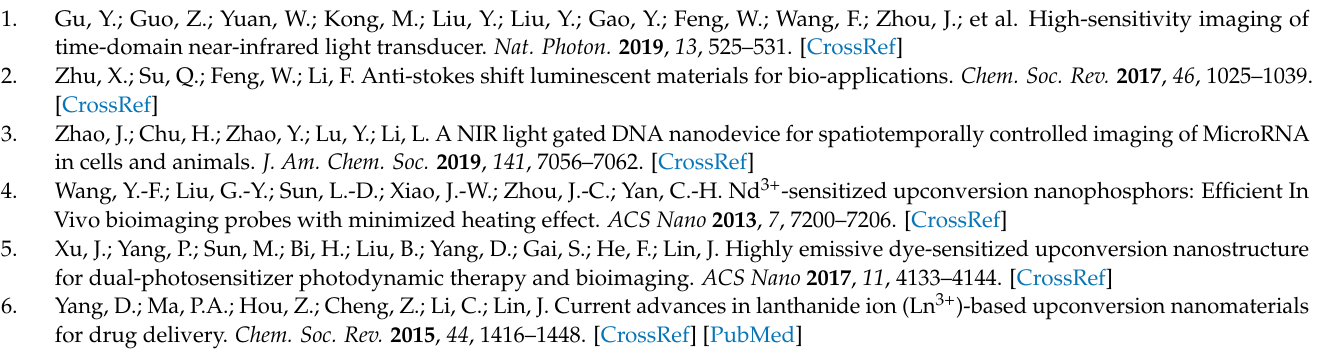
Figure S2: XRD of Gd-CSYS2S3 nanoparticles; Figure S3: EDX of Gd-CSYS2S3 nanoparticles; Figure